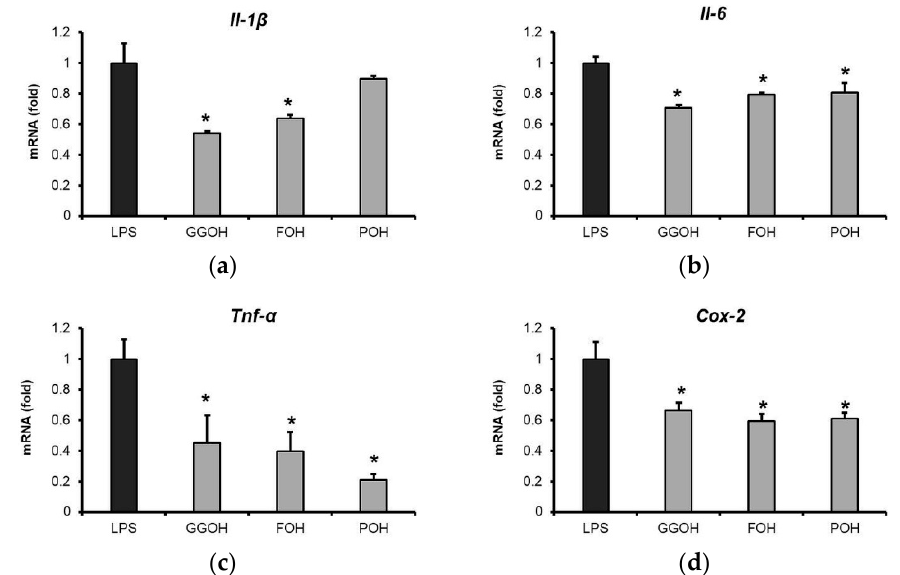
Figure 6. Suppression of pro-inflammatory cytokines mRNA upregulation by isoprenoid analogues. MG6 cells were administered isoprenoid analogues (10 µM) for 24 h followed by LPS treatment (10 ng/mL) for 3 h. ( a – d ) Pro-inflammatory cytokine mRNA expression following pre-treatment with isoprenoid analogues. mRNA levels were measured via qRT-PCR, normalized to the level of Eef1a1 (the internal standard), and expressed as fold-changes relative to the LPS-only treated group. Data are presented as the mean ± S.E.M, n = 3; * p < 0.05 vs. LPS-only treatment group. GGOH, geranylgeraniol; FOH, farnesol; and POH, phytol.